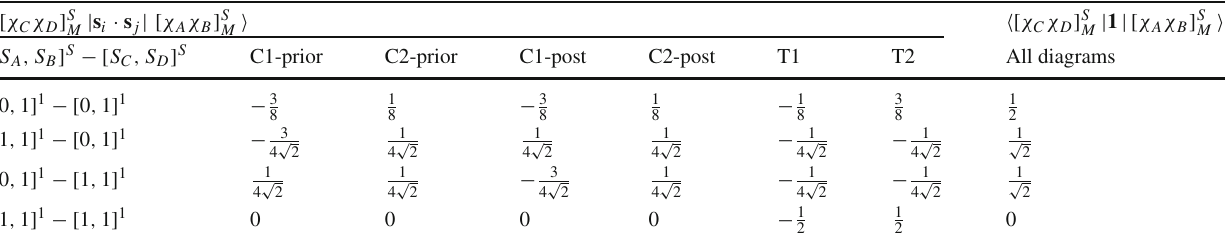
Table 2 The matrix elements (cid:6) [ χ C χ D ] S